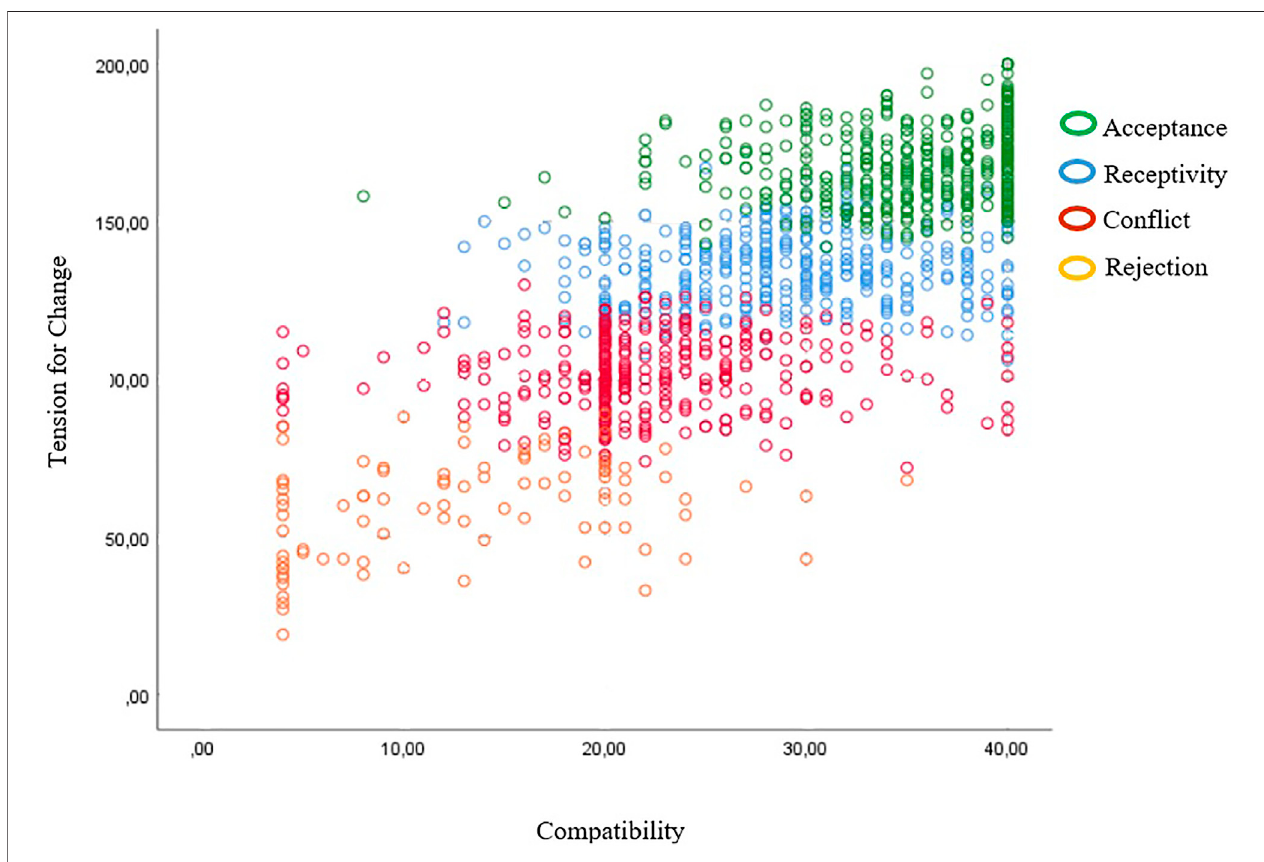
FIGURE 2 | Levels of implementation climate.